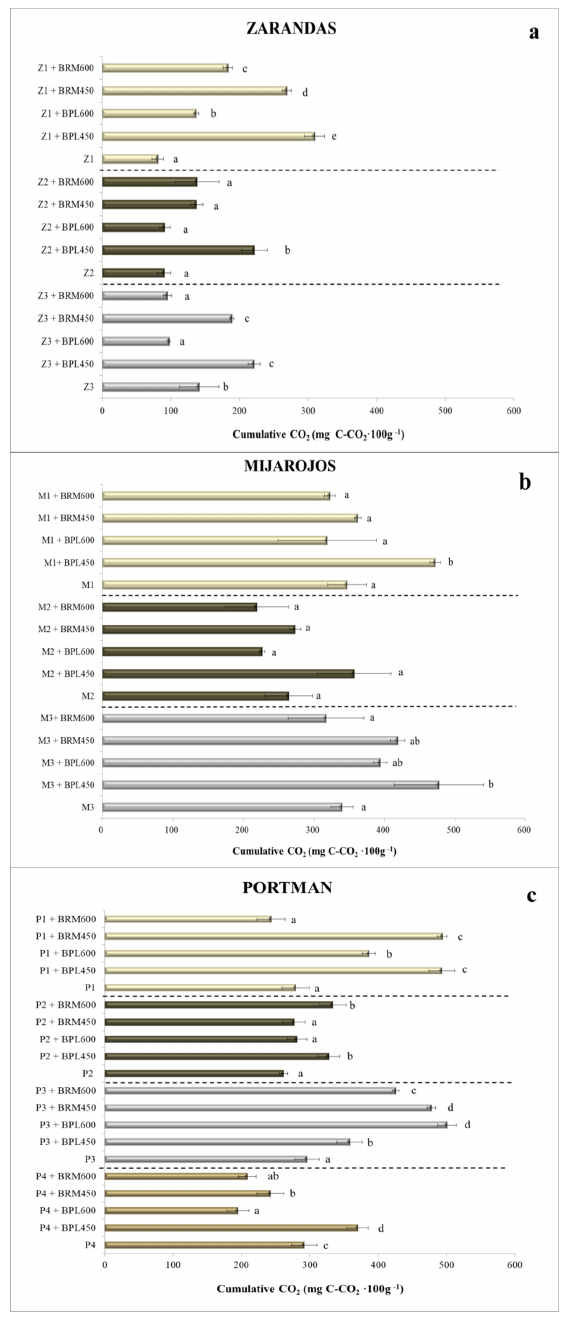
Figure 2. Cumulative CO 2 emissions of all treatments after 180 days: ( a ) Zarandas-Andalusia area. ( b ) Mijarojos-Cantabria area. ( c )